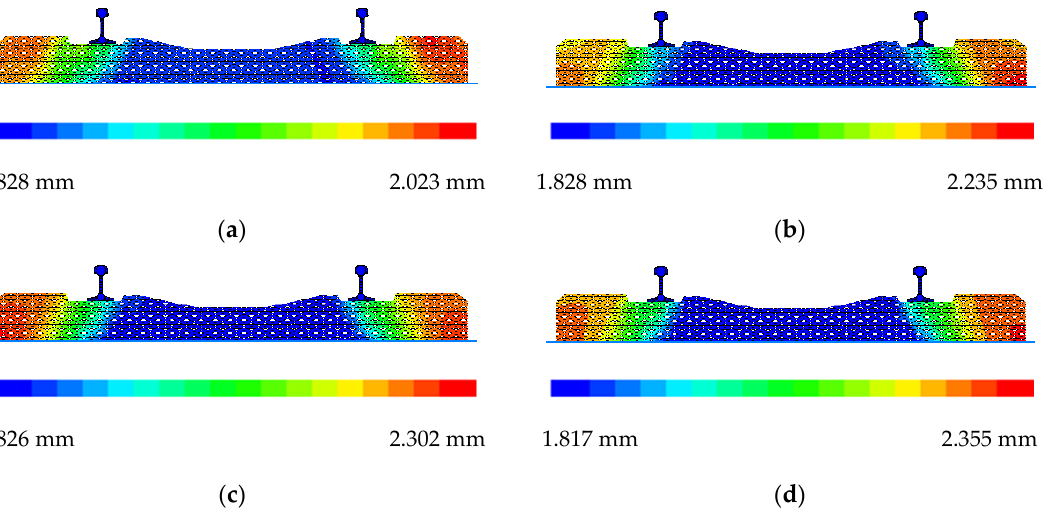
Figure 8. Sleeper-displacement cloud map corresponding to the same number of cycles at different loading frequencies. ( a ) 5 Hz. ( b ) 10 Hz. ( c ) 20 Hz. ( d ) 50 Hz.